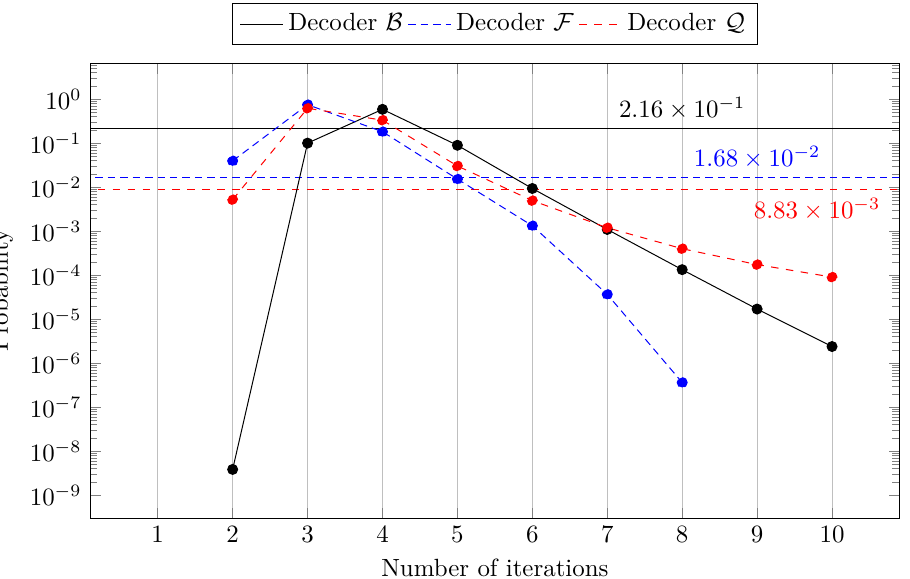
(b) With error amplification (chaining method). This data is based on 2 28 number of decoding trials each, for decoders B , F and Q .